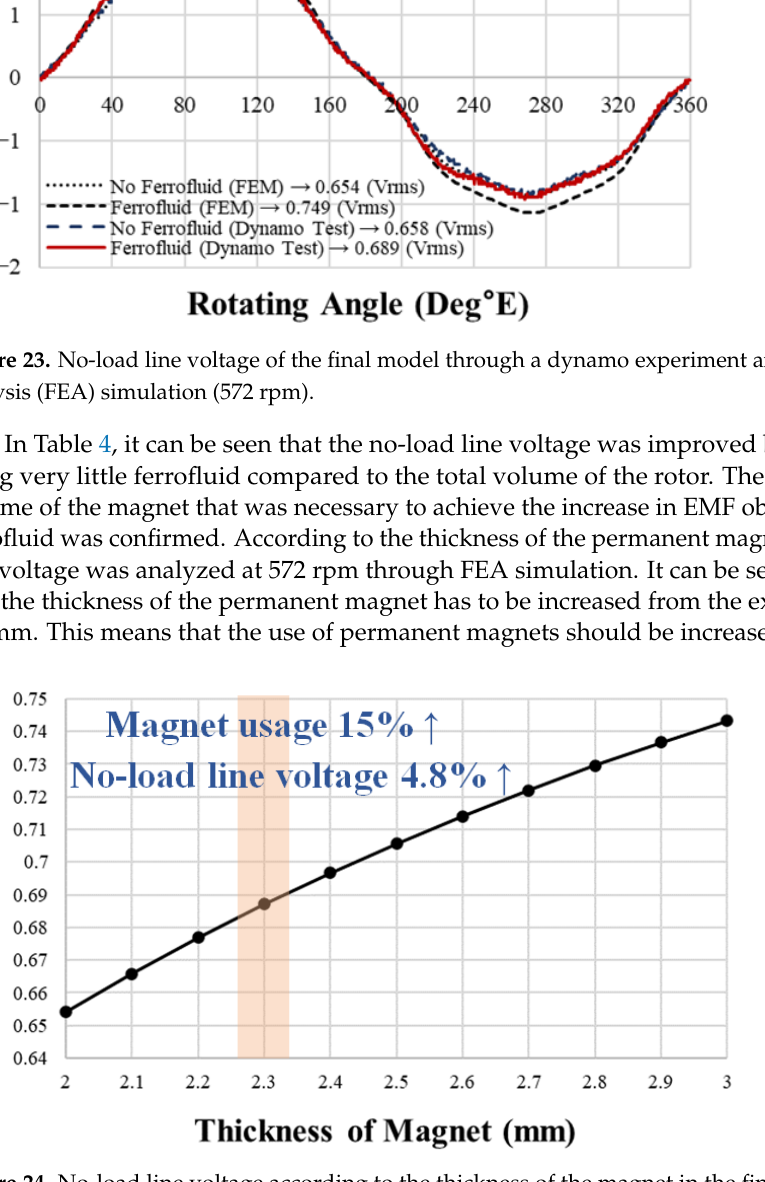
Figure 24. No-load line voltage according to the thickness of the magnet in the final model (no ferrofluid, 572 rpm).